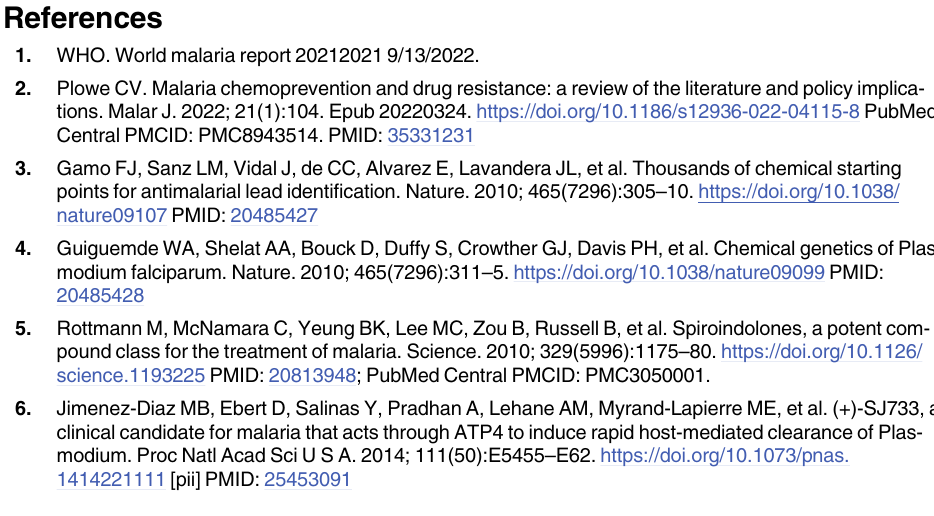
Table. Expected sizes: p1-p2 , 1949 bp; p3-p4 , 130 bp. (B) Southern blotting showing DNA from indicated parasites or the pXL-rTRPV1-HA transfection plasmid control, each digested with PacI. While the hDHFR probe does not hybridize to DNA from the wild-type Dd2 parent, both Dd2- TRP and Dd2- CapR yield a single band (size ~6 kbp) distinct from the 9.99 kbp seen with the transfection plasmid, indicating a single detected integration into the parasite genome. As the 9.99 kbp band is not detected in Dd2- TRP , this clone does not carry residual episomes. An additional smaller band ( < 4.9 kbp) in the plasmid control reflects undigested, supercoiled plasmid. An increased exposure image of the same blot is shown on the right to confirm probe specificity and an unchanged band in Dd2- CapR